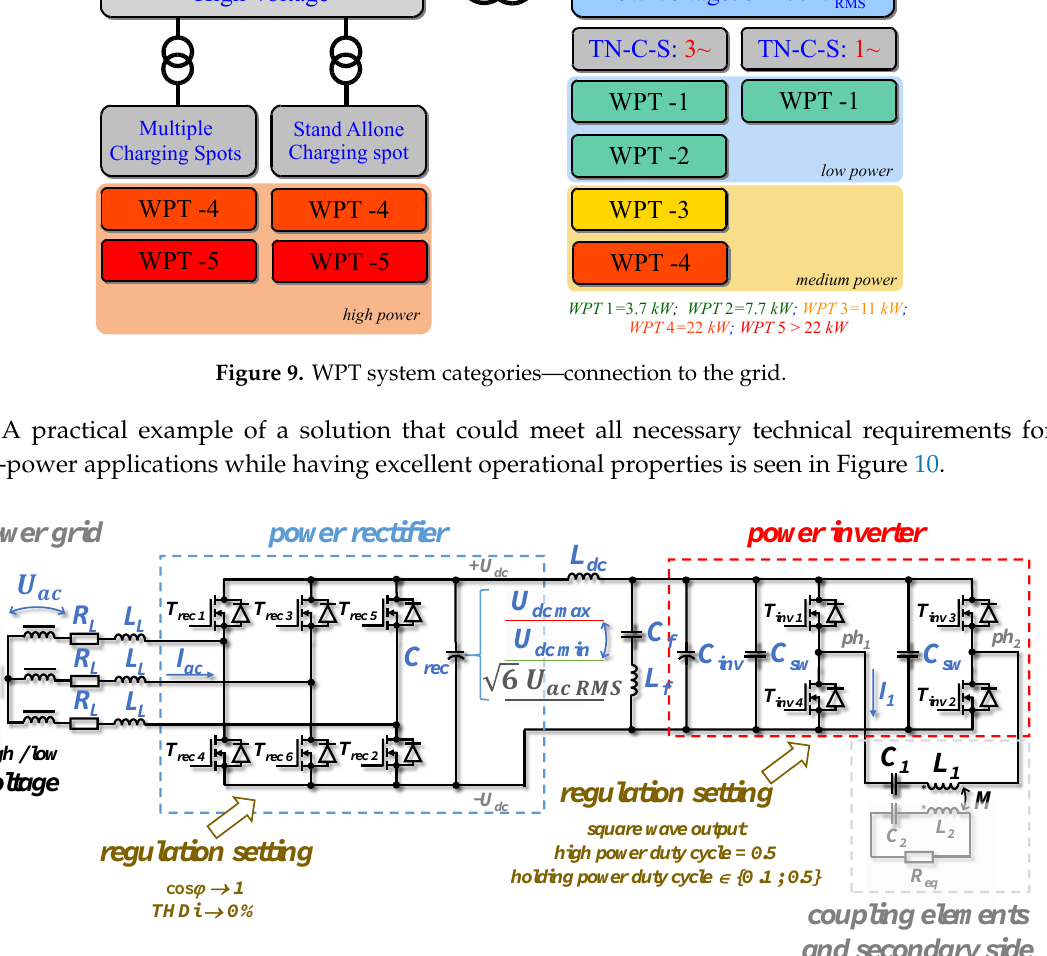
Figure 8. Power electronics configurations on the primary.